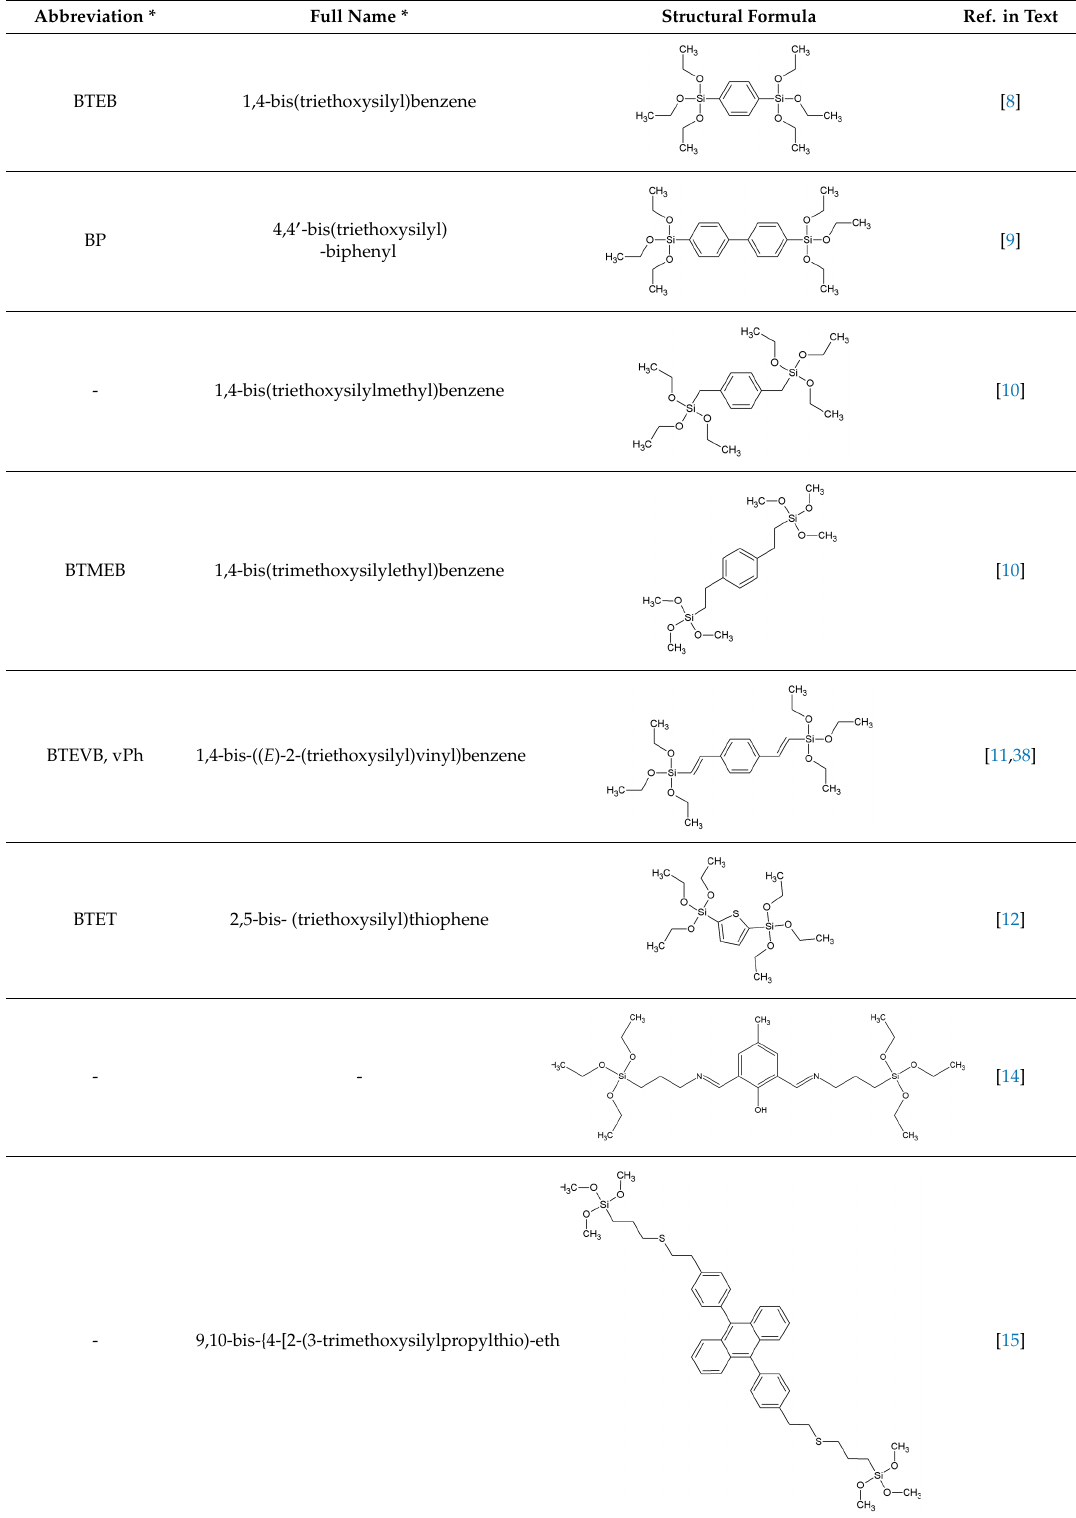
Table 1. Overview of the different aromatic precursors used to obtain PMO materials (* abbreviation and name given if available in the literature).